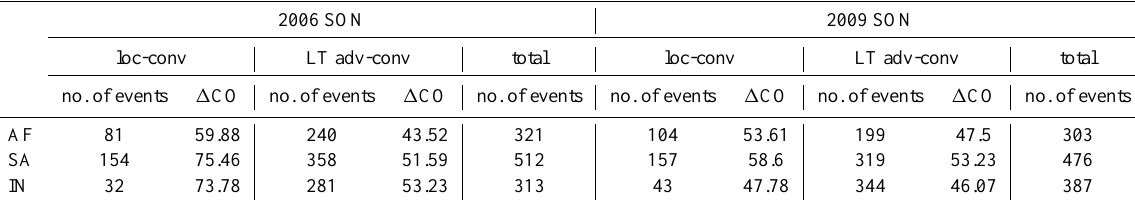
Table 2. Results of CO transport pathway analyses over central Africa (AF), South America (SA) and Indonesia (IN). From left to right, the first column indicates the regions, the second and seventh columns the number of “local convection” events, the third and eighth columns the average CO increase (ppbv) associated with “local convection” pathway, the fourth and ninth columns the number of “LT advection → convection” events, the fifth and tenth columns the average CO increase (ppbv) associated with “LT advection → convection” pathway, and the sixth and eleventh columns the total number of CO transport events during SON in each